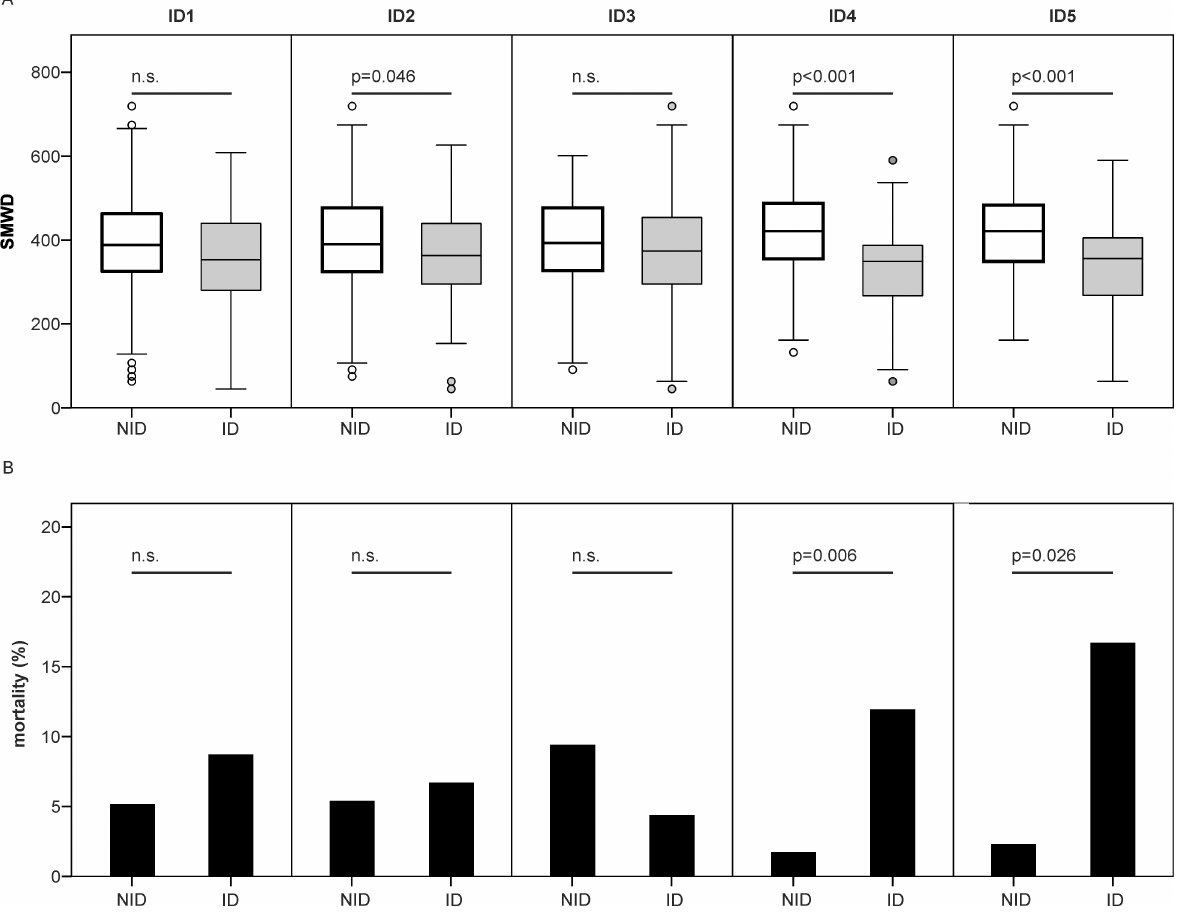
Fig 4. Six minute walking distance and mortality according to differential definitions of iron deficiency. (A) Six minute walking distance (SMWD) at follow up in 2015 according to differential definitions of iron deficiency (ID), (B) overall mortality during observation time according to differential definitions of ID. ID1-3 report serum ferritin and TSAT based ID definitions, whereas ID4 and ID5 present sTFR based ID definitions. ID1, serum ferritin < 30 μ g/L and TSAT < 16%; ID2, serum ferritin < 100 μ g/L and TSAT < 20%; ID3, serum ferritin < 100 μ g/L or serum ferritin 100– 299 μ g/L and TSAT < 20%, ID4, sTFR > 4.5 for women and > 5.0 for men; ID5, sTFRF index > 3.2 if CRP < 0.5mg/dL or sTFRF index > 2 if CRP > 0.5mg/dL, N = 103 (A), N = 153